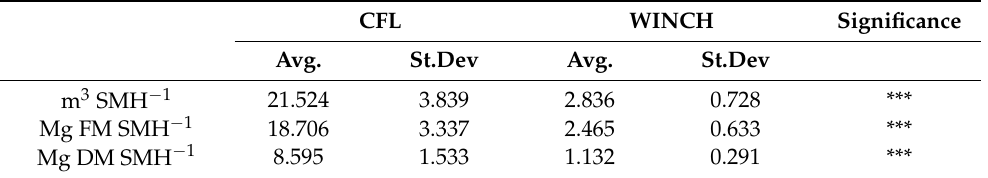
Table 3. Work productivity SMH (including delays) for the two investigated extraction systems. “***” indicates statistically significant differences at p > 0.001 between the mean values of the treatments. CFL